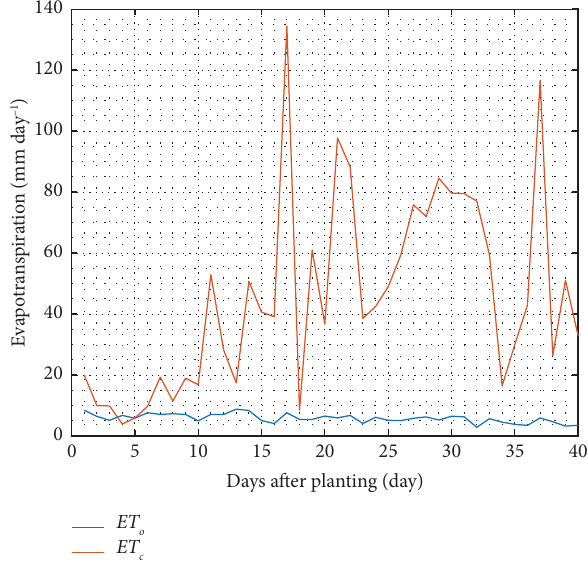
Figure 7: Fluctuations of reference (ET evapotranspiration.